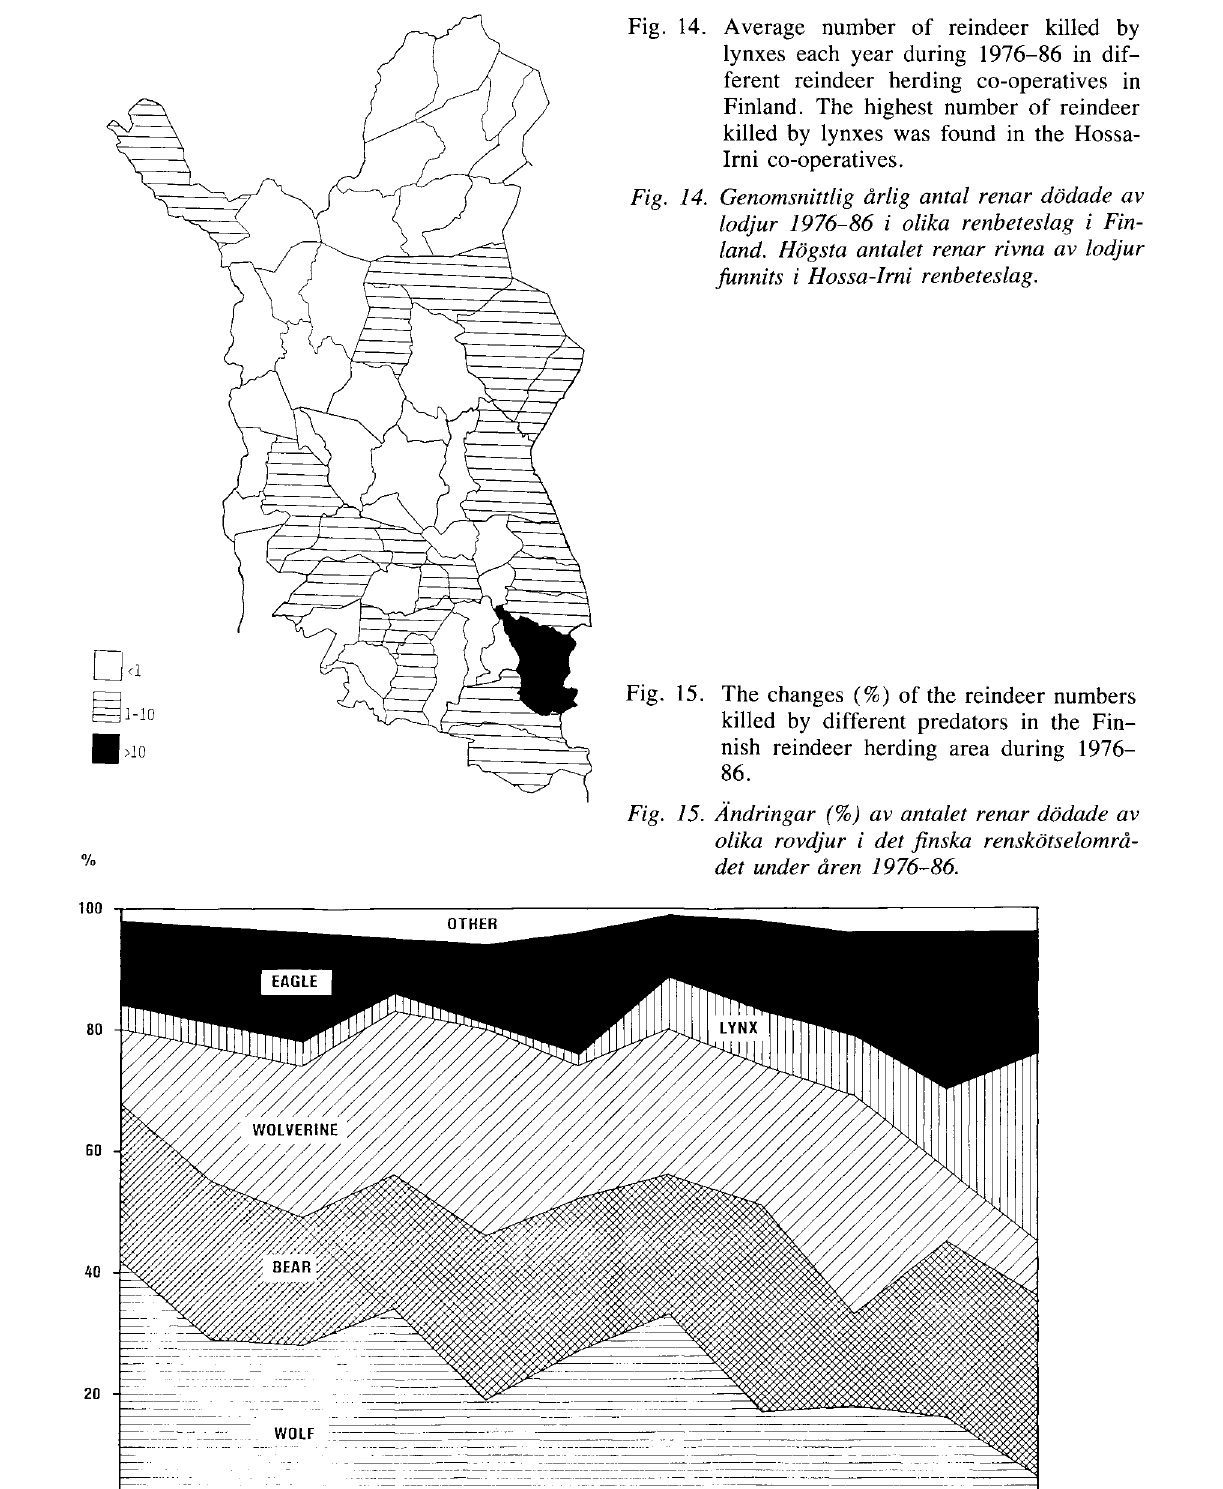
Fig. 14. Average number of reindeer killed by lynxes each year during 1976-86 in dif ferent reindeer herding co-operatives in Finland. The highest number of reindeer killed by lynxes was found in the Hossa- Irni co-operatives. Fig. 14. Genomsnittlig årlig antal renar dodade av lodjur 1976-86 i olika renbeteslag i Fin land. Hogsta antalet renar rivna av lodjur funnits i Hossa-lrni renbeteslag.